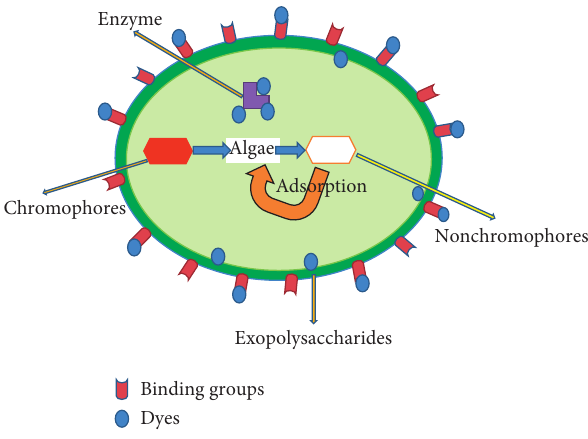
Figure 2: Mechanisms of dye adsorption by algae [28, Table 4: Algal functional group involved in decolorization of different synthetic dyes.